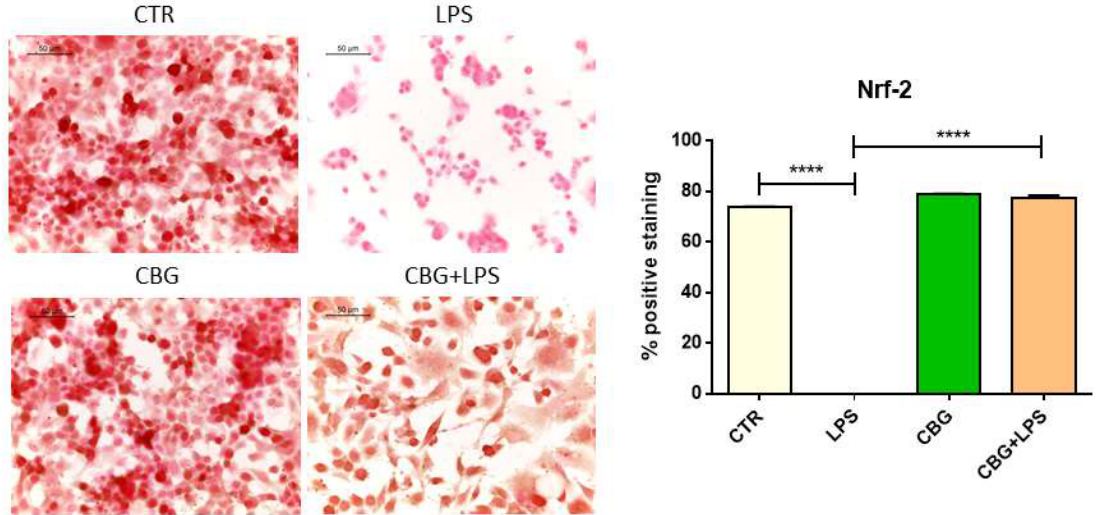
Figure 6. CBG pre-treatment was able to restore Nrf-2 expression in NSC-34 cells treated with the medium of LPS-stimulated RAW 264.7 macrophages. Control cells and NSC-34 cells treated with CBG alone expressed Nrf-2. On the contrary, the treatment with the medium of LPS-stimulated RAW 264.7 macrophages abolished its expression, but CBG pre-treatment restored its levels. The immunocytochemical assays were repeated three times. **** p <0.0001, NSC-34 cells treated with the medium of LPS stimulated macrophages vs. NSC-34 cells pre-treated with CBG and then exposed to the medium of LPS stimulated macrophages, NSC-34 cells treated with the medium of LPS stimulated macrophages vs. control; Scale bar: 50 µm.